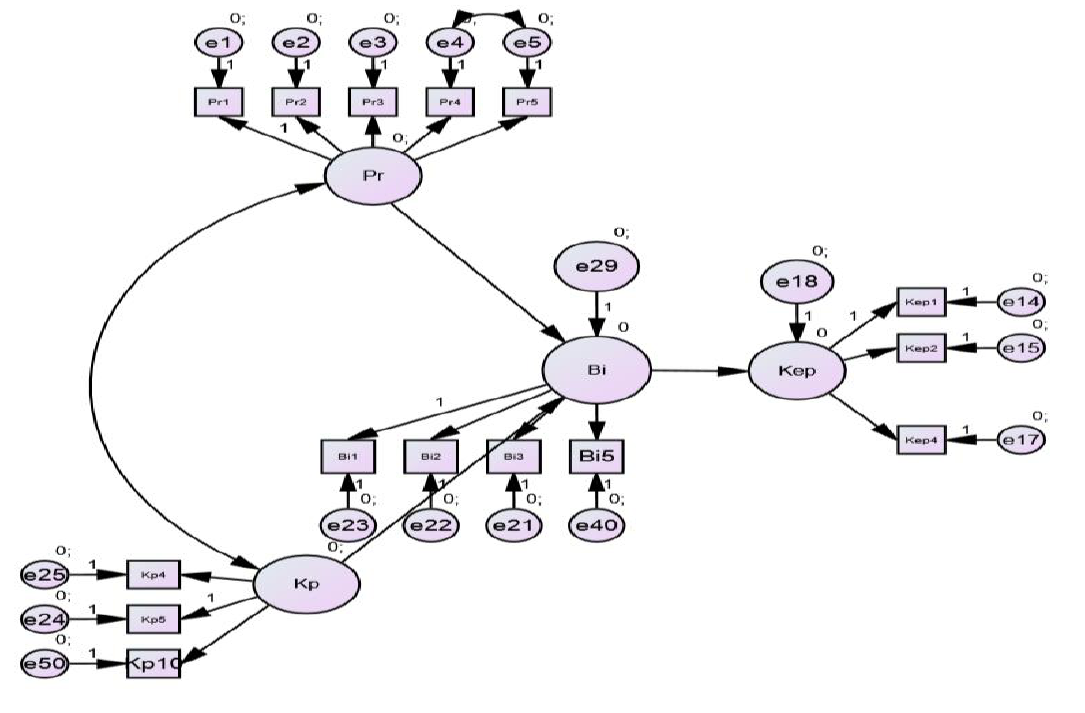
Figure 2: Research Model in AMOS